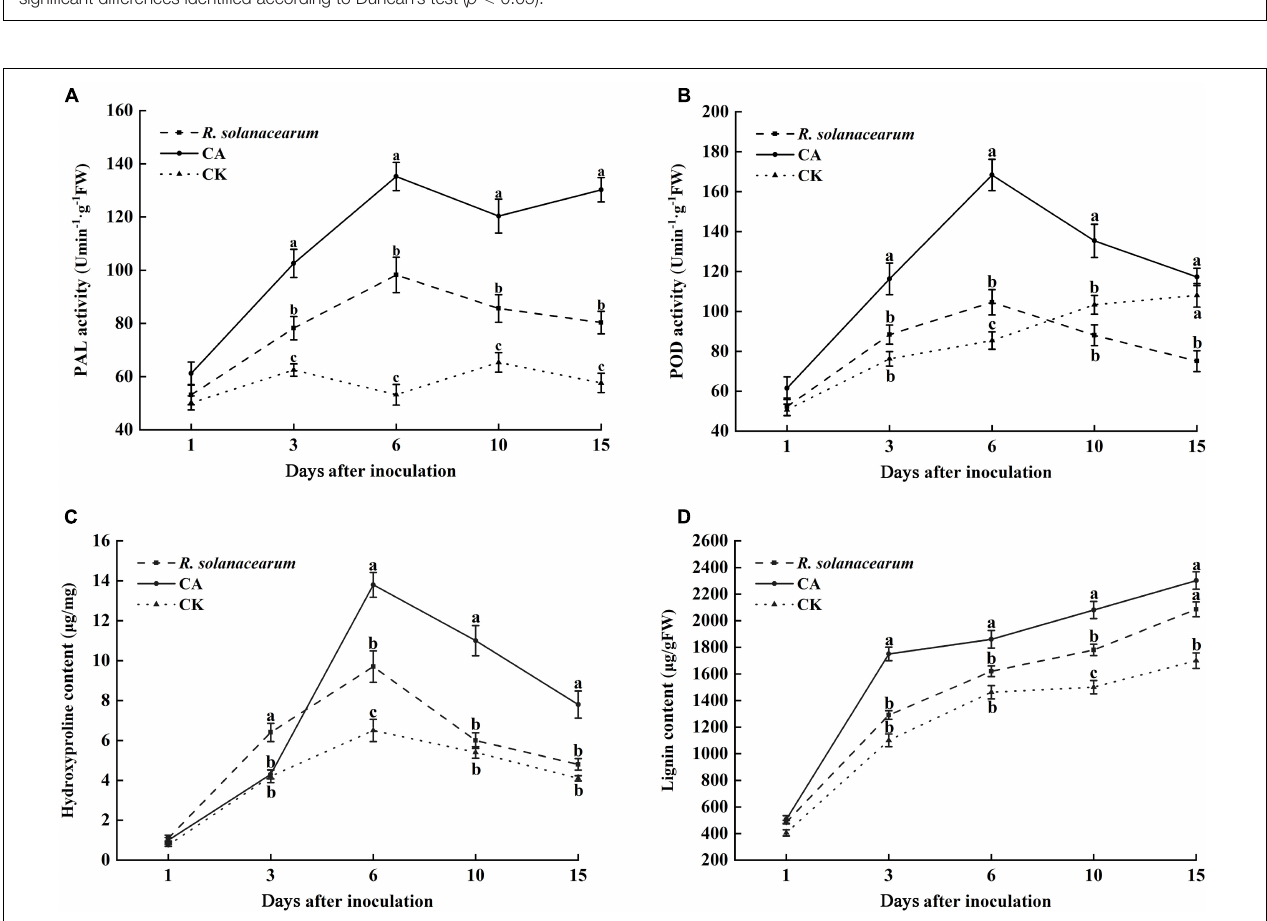
FIGURE 6 | Effect of caffeic acid on PAL (A) , POD (B) , hydroxyproline (C) , and lignin (D) activity from tobacco. CA, R. solanacearum, and CK represent caffeic acid concentrations of 200 µ g/mL, 1 mL of R. solanacearum (1 × 10 8 CFU/mL), and the control (sterilized distilled water), respectively. The mean value in both directions was calculated from triplicate plates. The error bars indicate the standard errors from three independent replicates, and the lowercase letters indicate significant differences identified according to Duncan’s test ( p < 0.05).